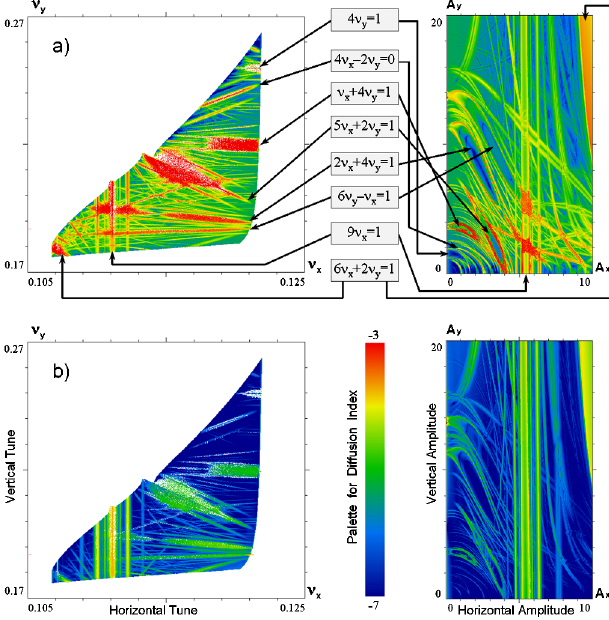
FIG. 5. Beam-beam resonances in the tune and amplitude planes for DA(cid:1)NE , crab ¼ 0 : 4 . The diffusion indexes were calculated from both betatron tunes (a), and from the horizontal tune only